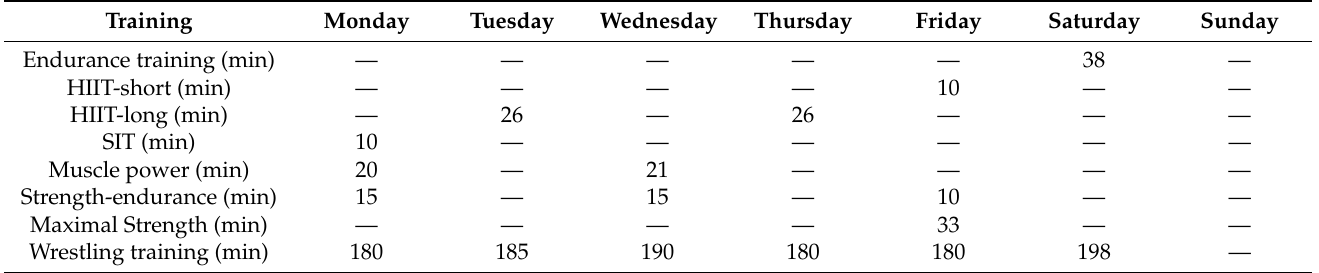
Table 2. Example of the distribution of weekly training